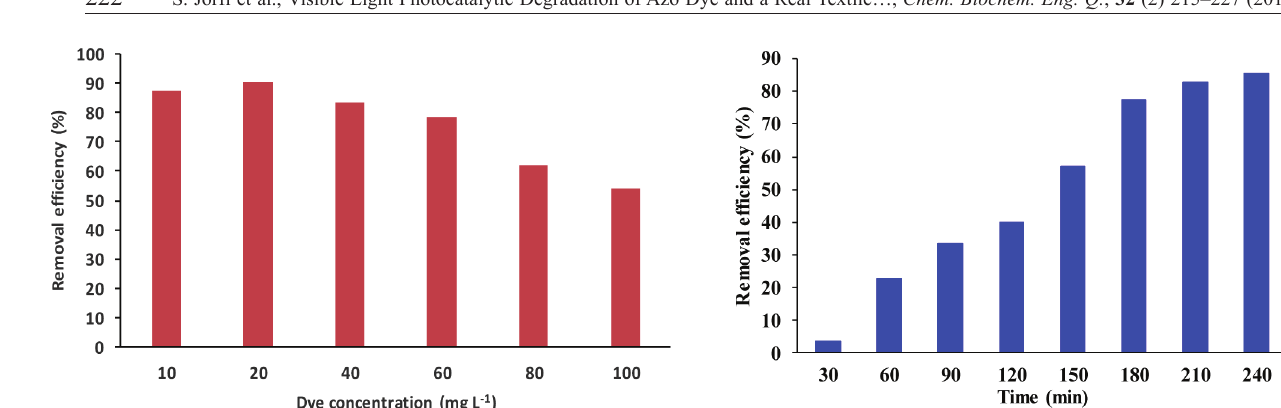
Fig. 8 – Mineralization of RR 198 azo dye using Mn, Mo, la/ TiO /AC under visible irradiation (pH: 3, photocatalyst dos- 2 age: 2 g L –1 , initial RR 198 concentration: 60 mg l –1